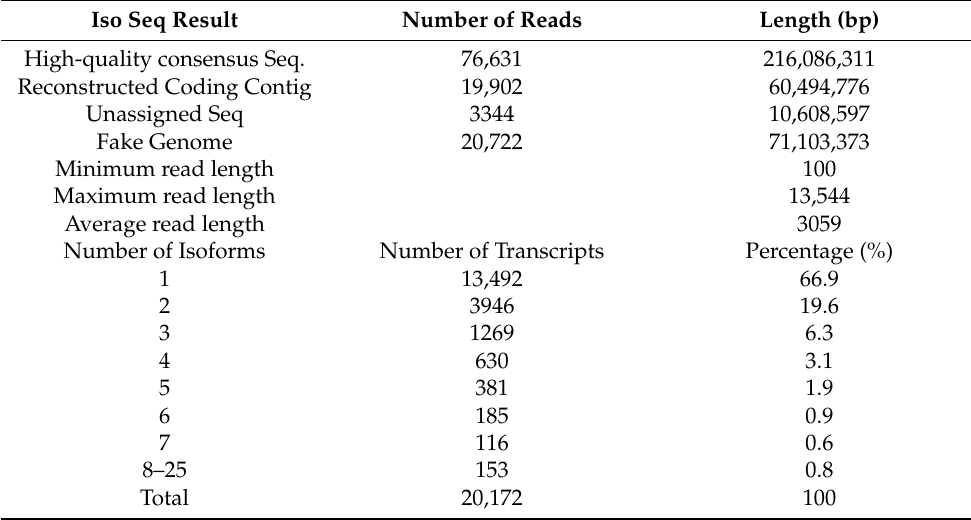
Table 2. IsoSeq results and statistics of isoforms in the transcriptomes of E. maculata . Iso Seq